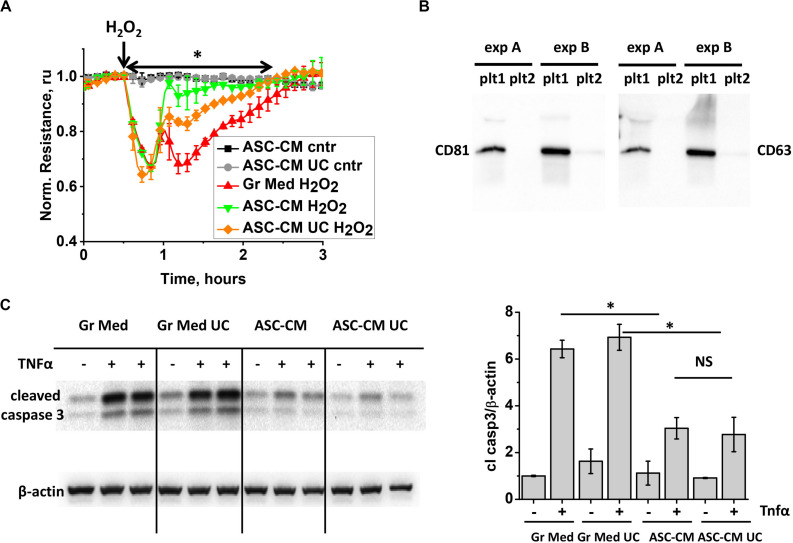
ASC-CM factors preserving transendothelial permeability are partially associated with extracellular vehicles, whereas factors preventing endothelial apoptosis are not. (A) HPAEC grown on gold electrodes of ECIS arrays were exposed to the original growth media (black, red), ASC-CM (green), or EV-depleted supernatant of ASC-CM subjected to 100,000 × g ultracentrifugation (gray, orange). After 72 h of preconditioning, media were substituted with EBM-2, and HPAEC were challenged with 250 μM H2O2 (red, green, orange) or vehicle (black, gray). Shown are the means ± SEM of three parallel recordings; the results were reproduced in at least three independent experiments. ∗Repeated measurement one-way ANOVA detected significant differences between responses of HPAEC exposed to the original ASC-CM (green) and ASC-CM subjected to ultracentrifugation (orange). (B) ASC-CM were subjected to 10,000 × g centrifugation to remove the cell debris, followed by 100,000 × g ultracentrifugation, and a subsequent round of 100,000 × g ultracentrifugation to remove EV. Pellets from the first (plt1) and second (plt2) rounds of 100,000 × g ultracentrifugation were analyzed by Western blotting with CD81 and CD63 antibodies. Results from two independent experiments (A,B) are presented. (C) HPAEC pretreated with the original and ultracentrifuged (UC) growth media and ASC-CM were challenged with 2 ng/ml TNFα for 4 h. Cell lysates were analyzed with antibodies to cleaved caspase 3 and β-actin (loading control). Data from three independent experiments were pooled and presented as cleaved caspase 3/β-actin ratio mean ± SEM. One-way ANOVA with Tukey post hoc was used to detect whether differences between indicated columns are significant ∗(p < 0.05) or not significant (NS).